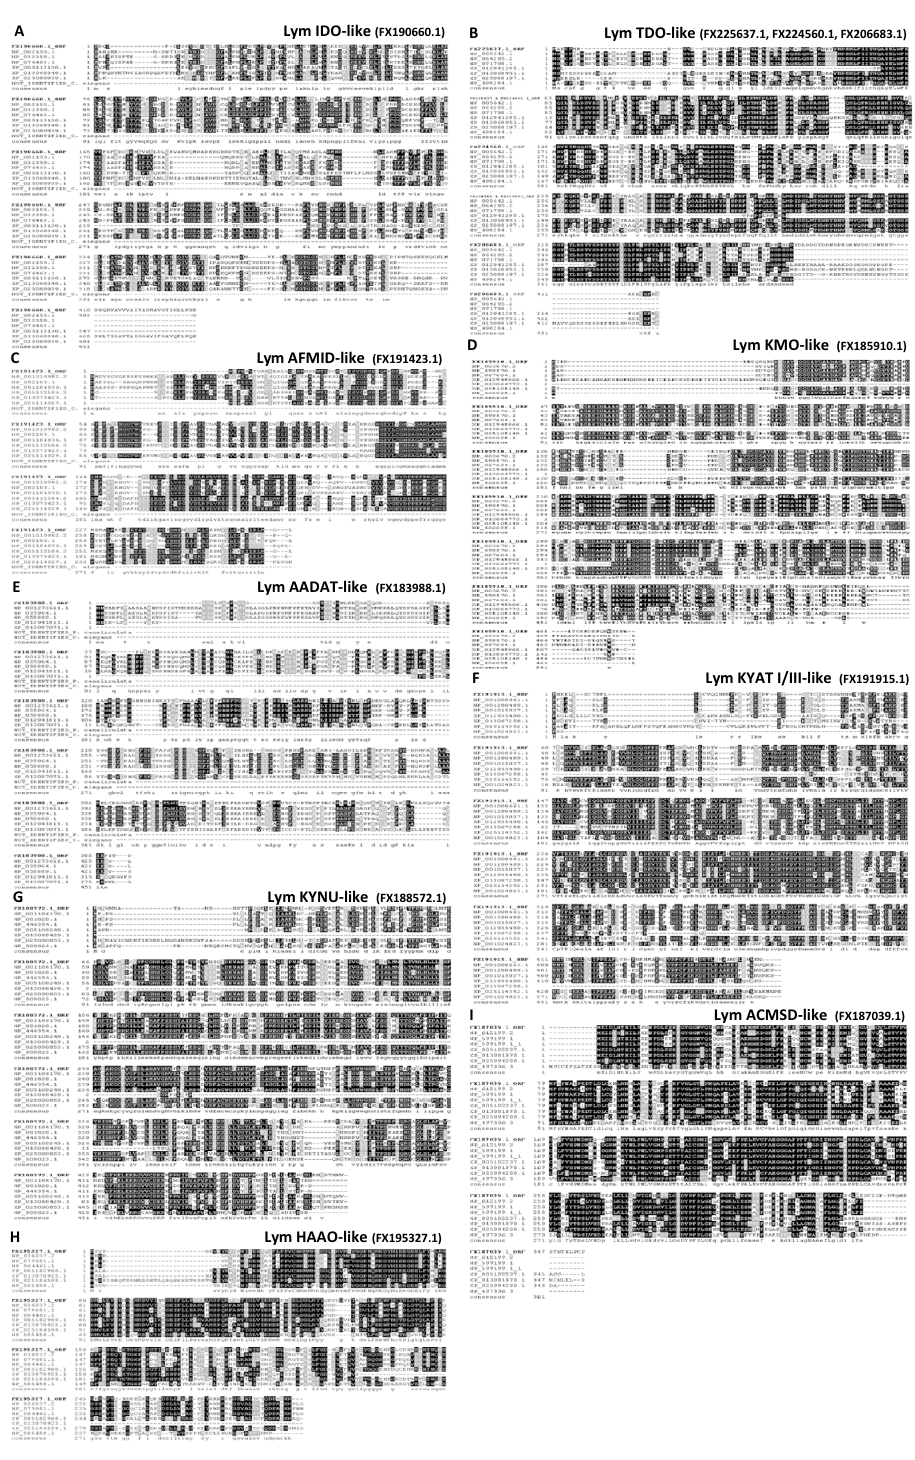
Figure 3. Multiple sequence alignments of each putative KP enzyme in L. stagnalis with the amino acid sequences of the corresponding enzyme from H. sapiens , M. musculus , R. norvegicus , A. californica , B. glabrata , P. canaliculata , and C. elegans . ( A ) Lym IDO-like, ( B ) Lym TDO-like, ( C ) Lym AFMID-like, ( D ) Lym KMO- like, ( E ) Lym AADAT-like, ( F ) Lym KYAT I/III-like, ( G ) Lym KYNU-like, ( H ) Lym HAAO-like, ( I ) Lym ACMSD-like. Box shade alignment displays show conserved residues (identical black, similar